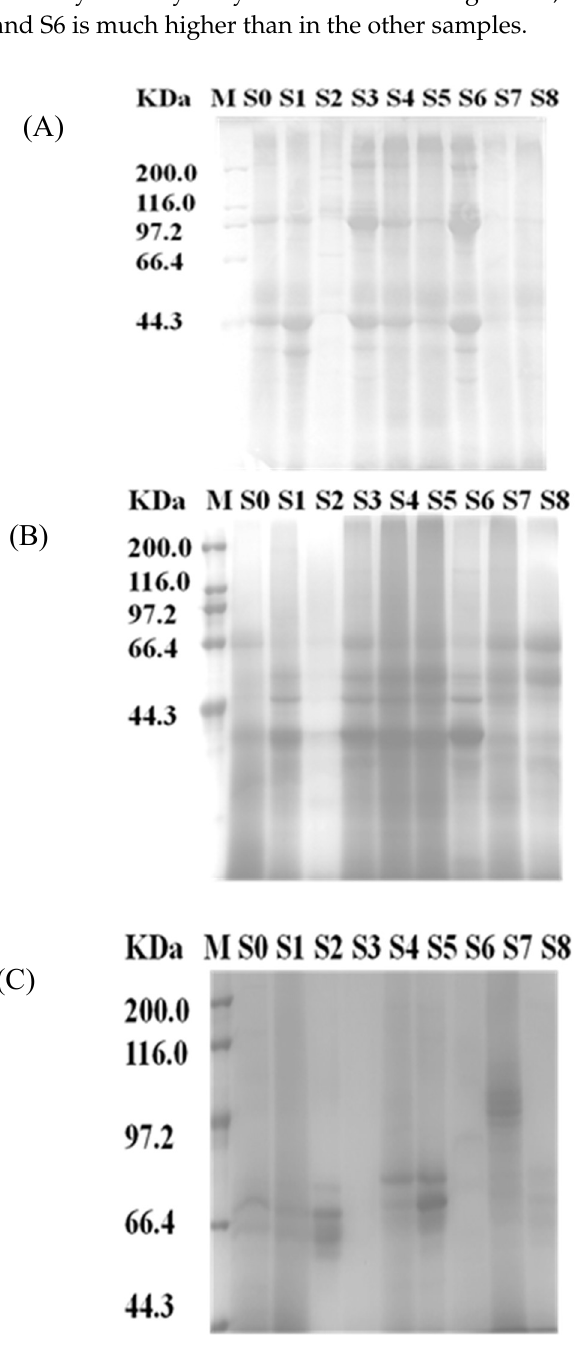
Figure 2. ( A ) Soluble proteins in 45 °C water at pH 8.5; ( B ) soluble proteins in 25 °C water at pH 7.0 ( C ) proteins and peptides in the enzymatic hydrolysates. S0—Whole tissue; S1—Foot; S2—Byssus; S3—Pedal retractor muscle; S4—Mantle; S5—Gill; S6—Adductor muscle; S7—Viscera; S8—Other parts.